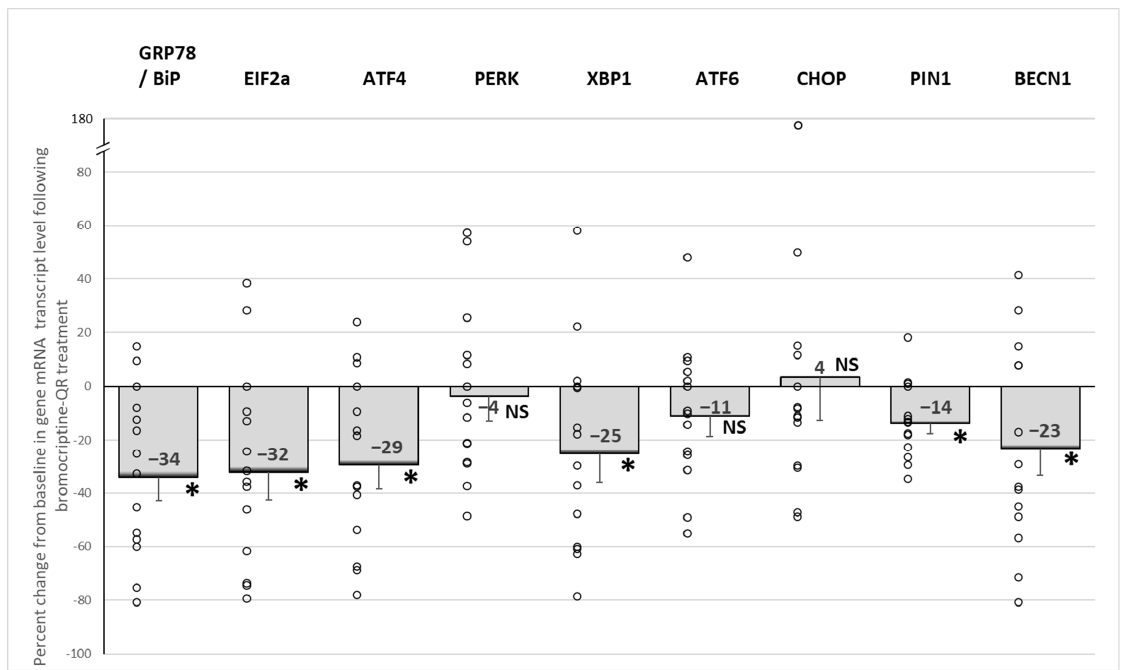
Figure 3. Effect (change from baseline) of 4 months of bromocriptine-QR treatment on PBMC ER stress-associated unfolded protein response gene mRNA level. * Significant, 2-tailed t -test; NS, Not Significant.